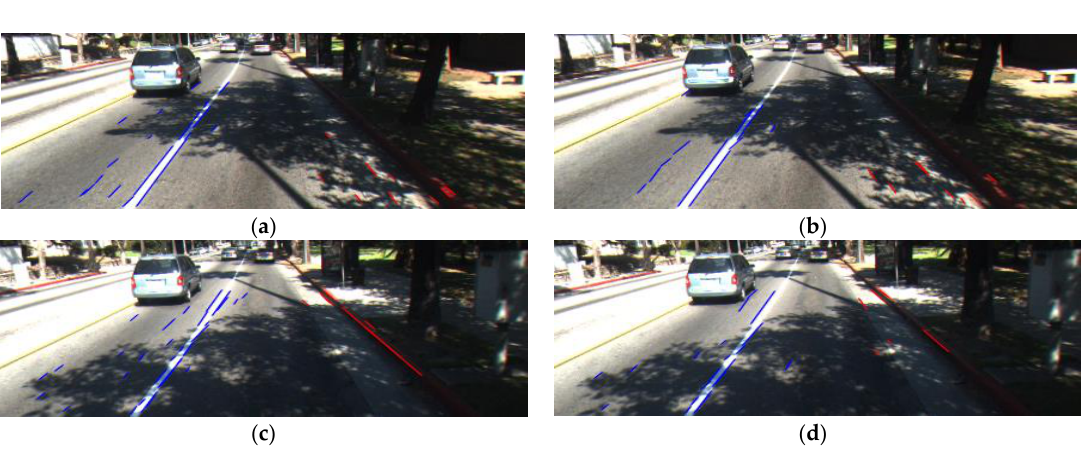
Figure 13. Examples of comparison between before and after adaptively adjusting the parameters by the output of FIS: ( a ) Default parameters for LSD; ( b ) Adjusted parameters for LSD; ( c ) Default parameters for CannyLines detector; ( d ) Adjusted parameters for CannyLines detector.